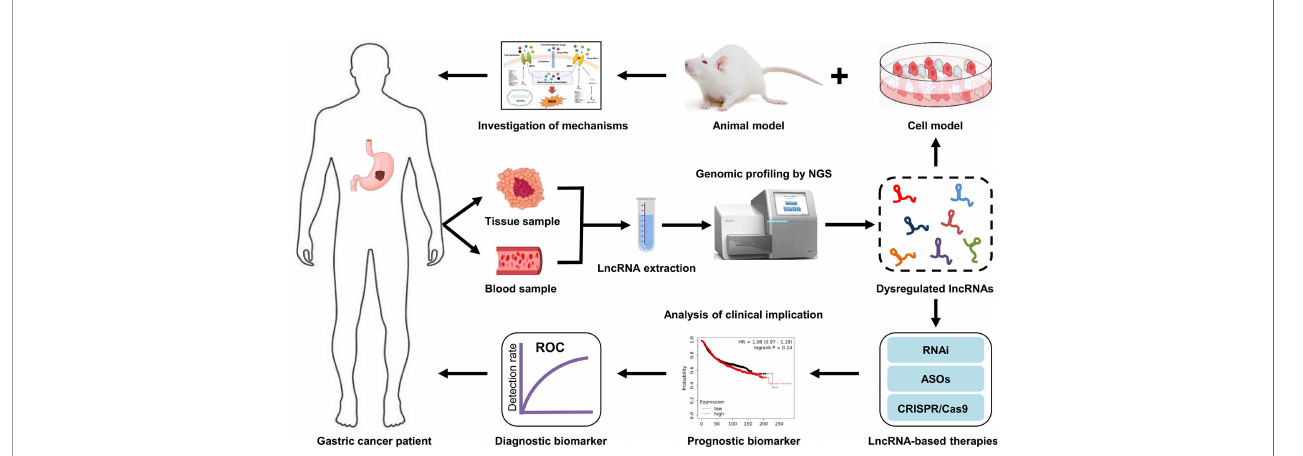
FIGURE 5 | Clinical implications of lncRNAs in GC drug resistance. LncRNAs are extracted from tissue or blood samples of GC patients. Next, the expression pro fi les of lncRNA are analyzed by high-throughput sequencing technologies. Subsequently, the dysregulated lncRNAs are screened via bioinformatics analysis. The mechanisms of drug resistance-related lncRNAs in GC are investigated using cell and animal models. The aberrantly expressed lncRNAs that can serve as diagnostic or prognostic biomarkers for drug resistant-GC patients are identi fi ed. Additionally, targeting speci fi c lncRNAs may be a new therapeutic strategy for GC patients, particularly those with a poor response to